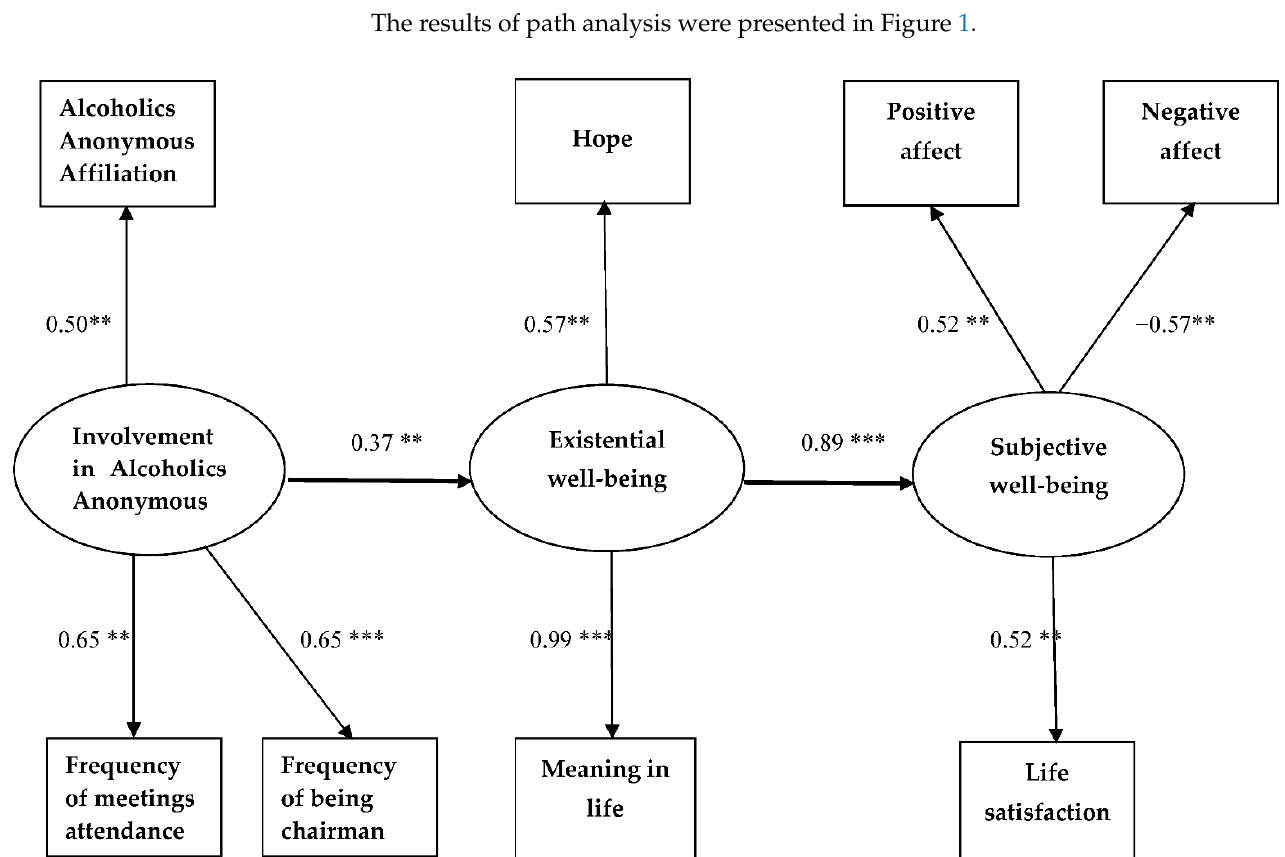
Figure 1. Path analysis results. Note: The standardized regression coefficients are presented. ** p < 0.01, *** p < 0.001. (Source: author’s